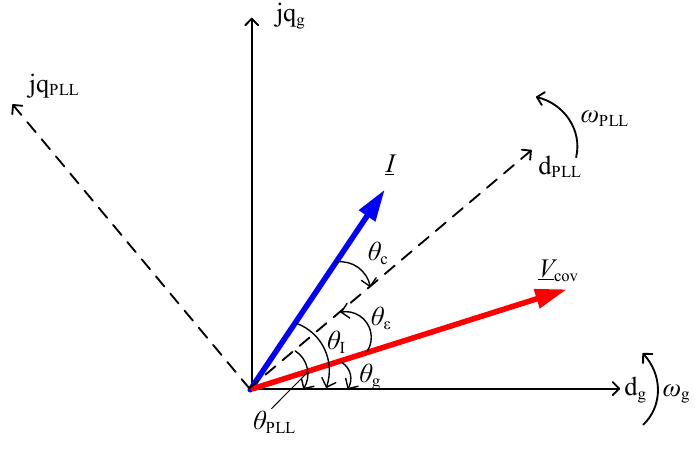
Figure 3. Rotating frames of converter and grid.